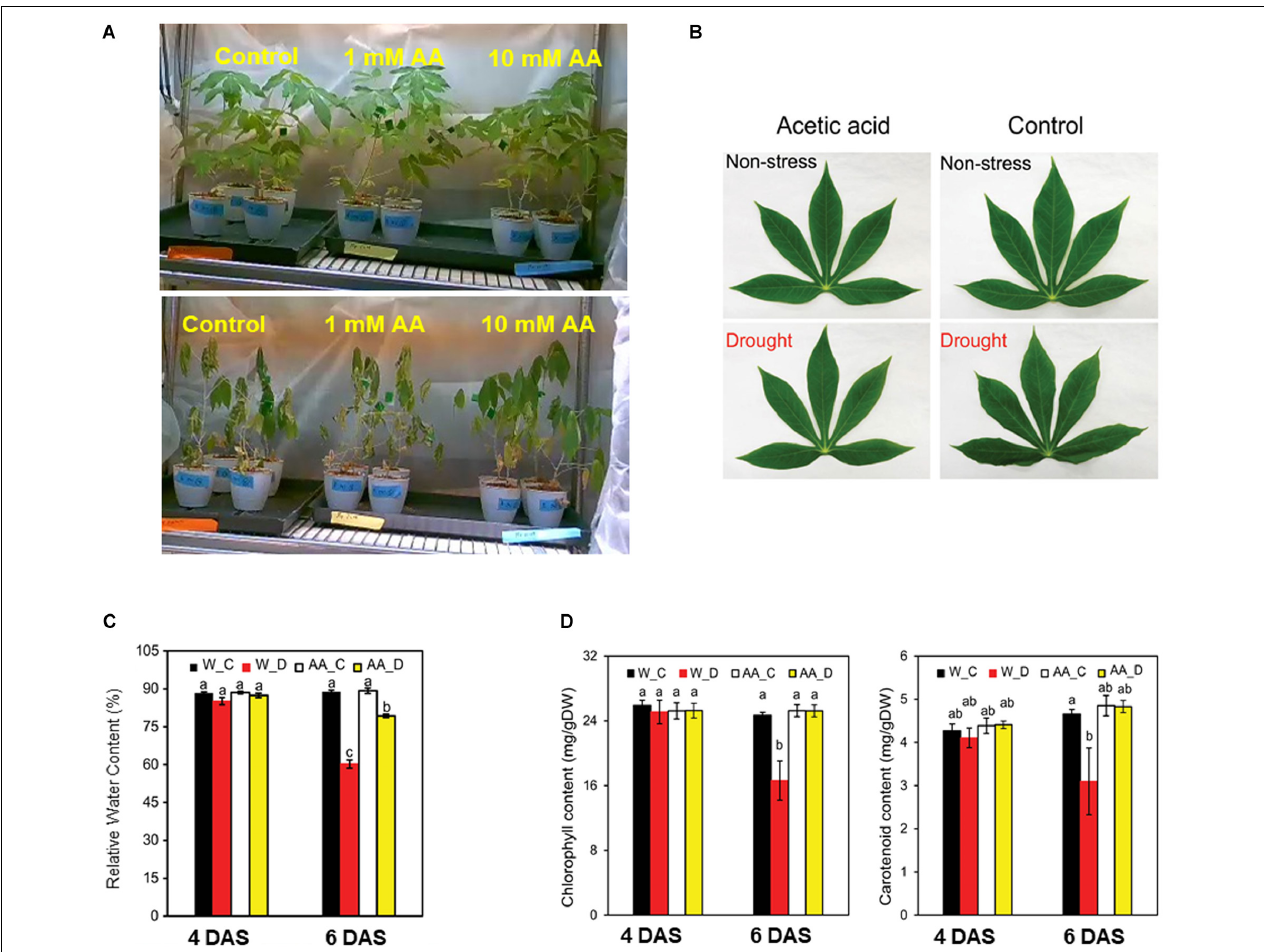
FIGURE 2 | (A) Representative cassava plants that were either treated with 1- or 10-mM acetic acid or water-treated (control) at 9 days after the initiation of soil drying (bottom) and prior to drying (upper). (B) Representative leaf from 10 mM acetic acid-treated and water-treated (control) cassava plants at 4 and 6 days after the commencement of soil drying. (C) Relative water content (RWC) of the fifth leaf of cassava plants at 4 and 6 days after the commencement of the soil drying treatment. Data represent the mean ± SE ( n = 4). (D) Chlorophyll and carotenoid levels of the fifth leaf of cassava plants at 4 and 6 days after the commencement of the soil drying treatment. Data represent the mean ± SE ( n = 4). Different superscripted letters (a, b, and c) within a column in (C,D) indicate statistically significant differences among the treatments as determined by a Duncan’s multiple range test ( P <